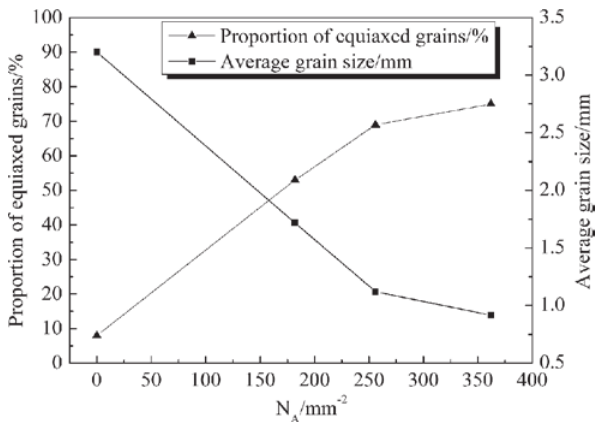
Fig. 4: Average grain size and proportion of equiaxed grains vs N A in unit